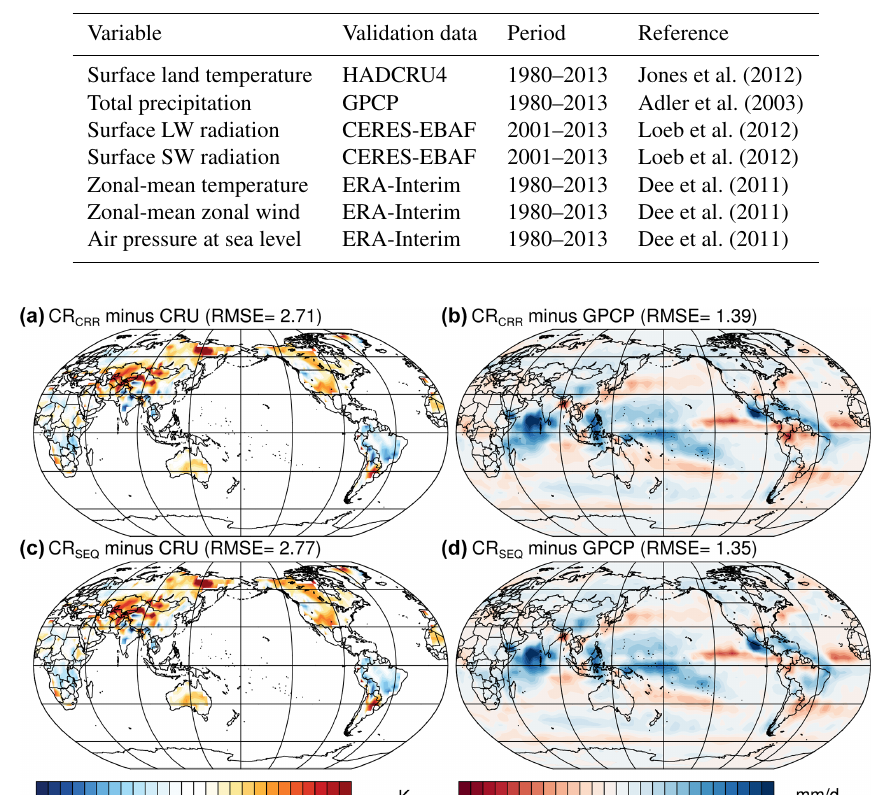
Table 1. Observation and reanalysis data for model evaluation.